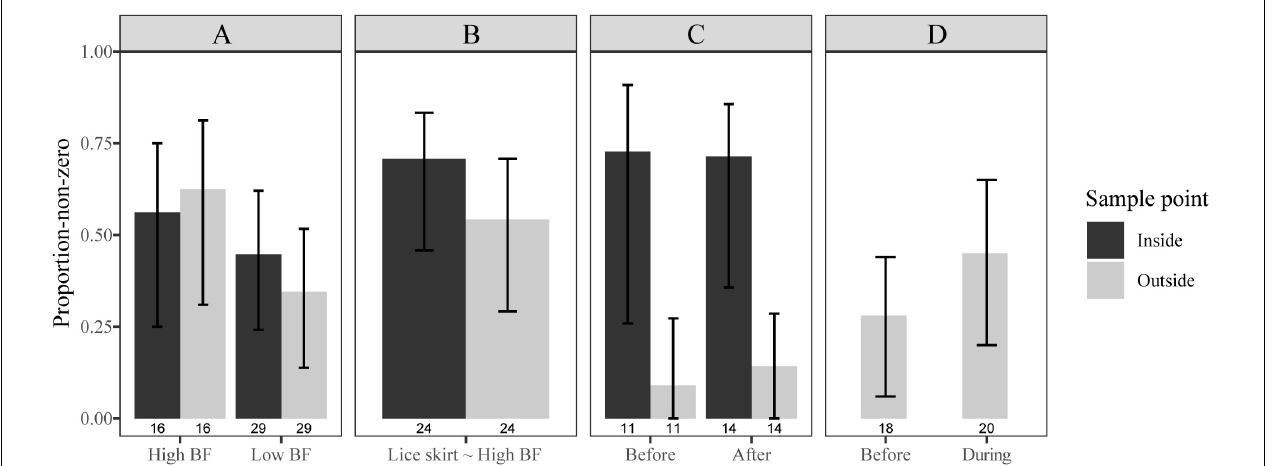
FIGURE 3 | Proportion-non-zero (proportion of replicates with at least one sea louse) for samples taken from the inside (black bar) and outside (gray bar). Divided for experiment and site [(column panels, NoskirtA and NoskirtB (A) , Liceskirt7 (B) , Liceskirt10 (C) , NoskirtC (D) ], and biofouling category [row panels, Hight biofouling